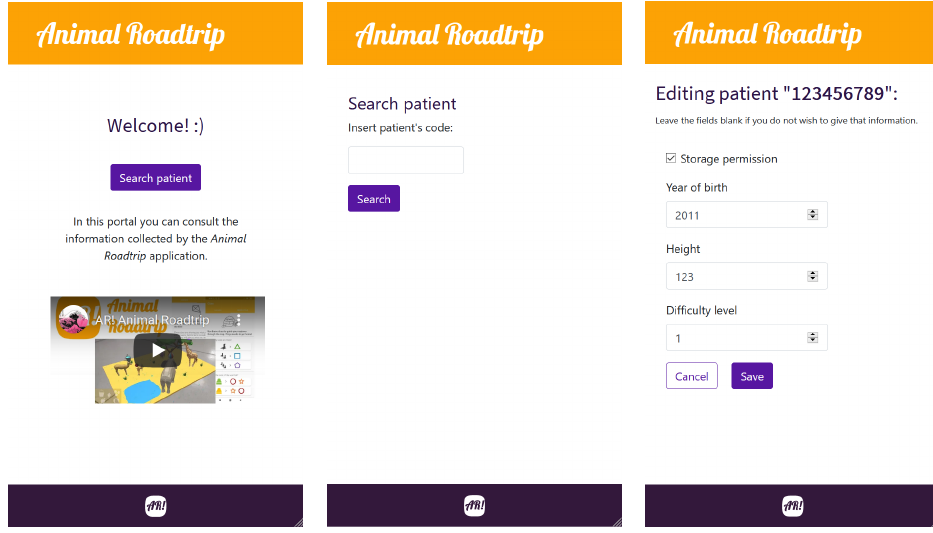
Figure 4. Overview of the Home page ( left ), Search page ( center ) and Edition page ( right